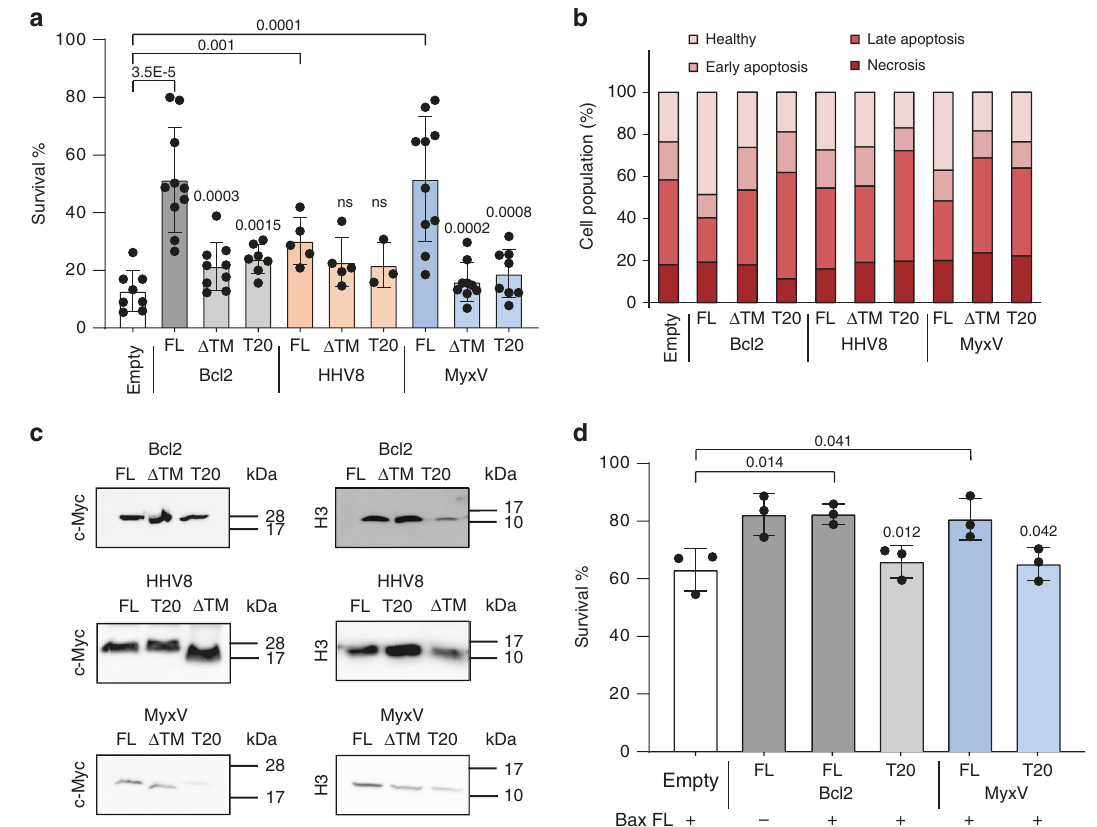
Fig. 7 The role of vBcl2 TMD in apoptotic control. a Role of vBcl2 TMD in control of doxorubicin-induced apoptosis. Cells were transfected with Bcl2, HHV8, and MyxV with (FL) or without the TMD ( Δ TMD), or with the TMD substituted by the TMD of T20 (T20). Cells were then treated with doxorubicin and the percentage of surviving cells was calculated by Trypan blue staining. The survival percentage mean and standard deviation of at least three independent experiments are shown ( n ≥ 3). Solid dots represent the results of individual experiments. Transfection with an empty plasmid (Empty) was used as a negative control. Statistical differences are based on a two-tailed homoscedastic t -test ( p -values are indicated above the corresponding bar, ns non-signi fi cant). b Alternatively, the percentage of cells in healthy, early apoptotic, late apoptotic, or necrotic states was measured by fl ow cytometry using propidium iodide staining and phosphatidyl serine labeling (FITC-Annexin V). The average percentage of cells in each of the aforementioned populations is shown. c Western blot analysis of protein levels. Histone 3 (H3) was used as a loading control ( n = 3). d Role of MyxV TMD in Bax-induced apoptosis. Cells were transfected with Bcl2 and MyxV (FL) or with the TMD substituted by the TMD of T20 (T20) and co-transfected with ( + ) or without ( − ) Bax-FL as an apoptosis stimulus. Survival percentage mean and standard deviation of three independent experiments are shown ( n = 3). Solid dots represent the results of individual experiments. Statistical differences are based on a two-tailed homoscedastic t -test ( p -values are shown above the corresponding